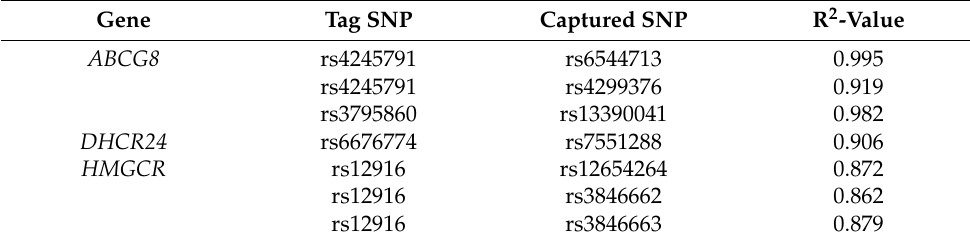
Table 1. Tag SNPs and their captured SNPs with their corresponding r 2 -values. Gene Tag SNP Captured SNP R 2